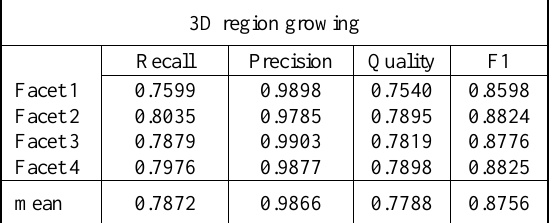
Table 3 . Evaluation metrics for 3D region growing method.